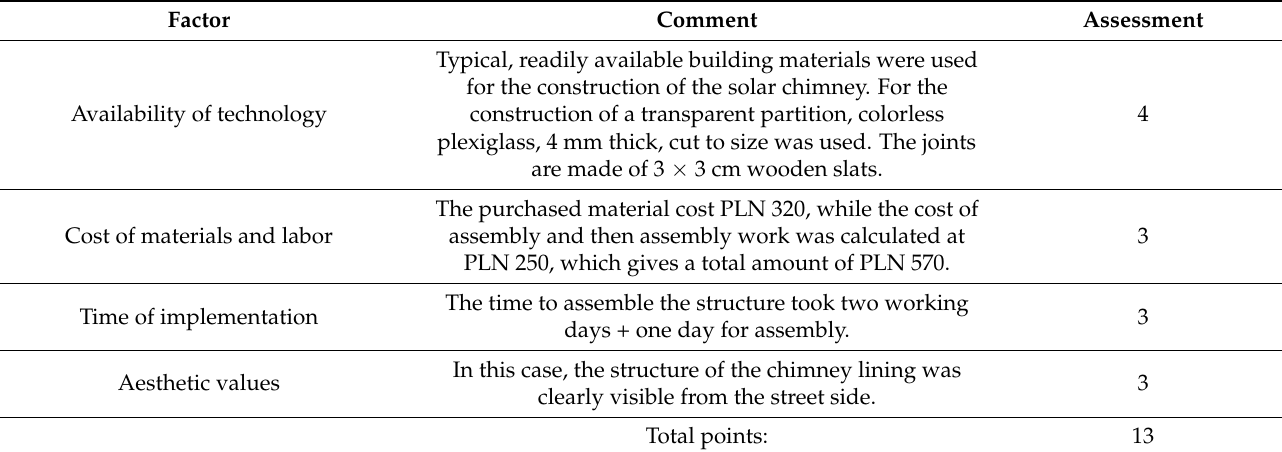
Table 4. Self-assessment of the applied solution to strengthen the chimney draft.